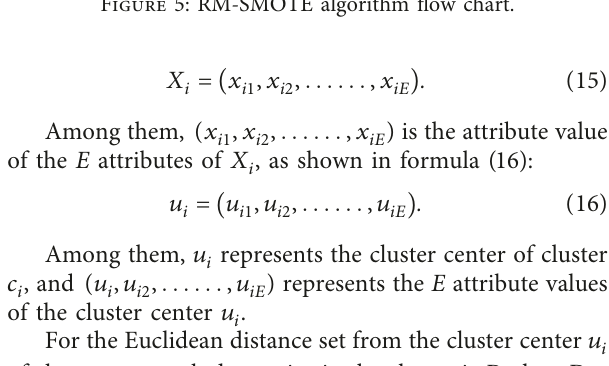
Figure 5: RM-SMOTE algorithm flow